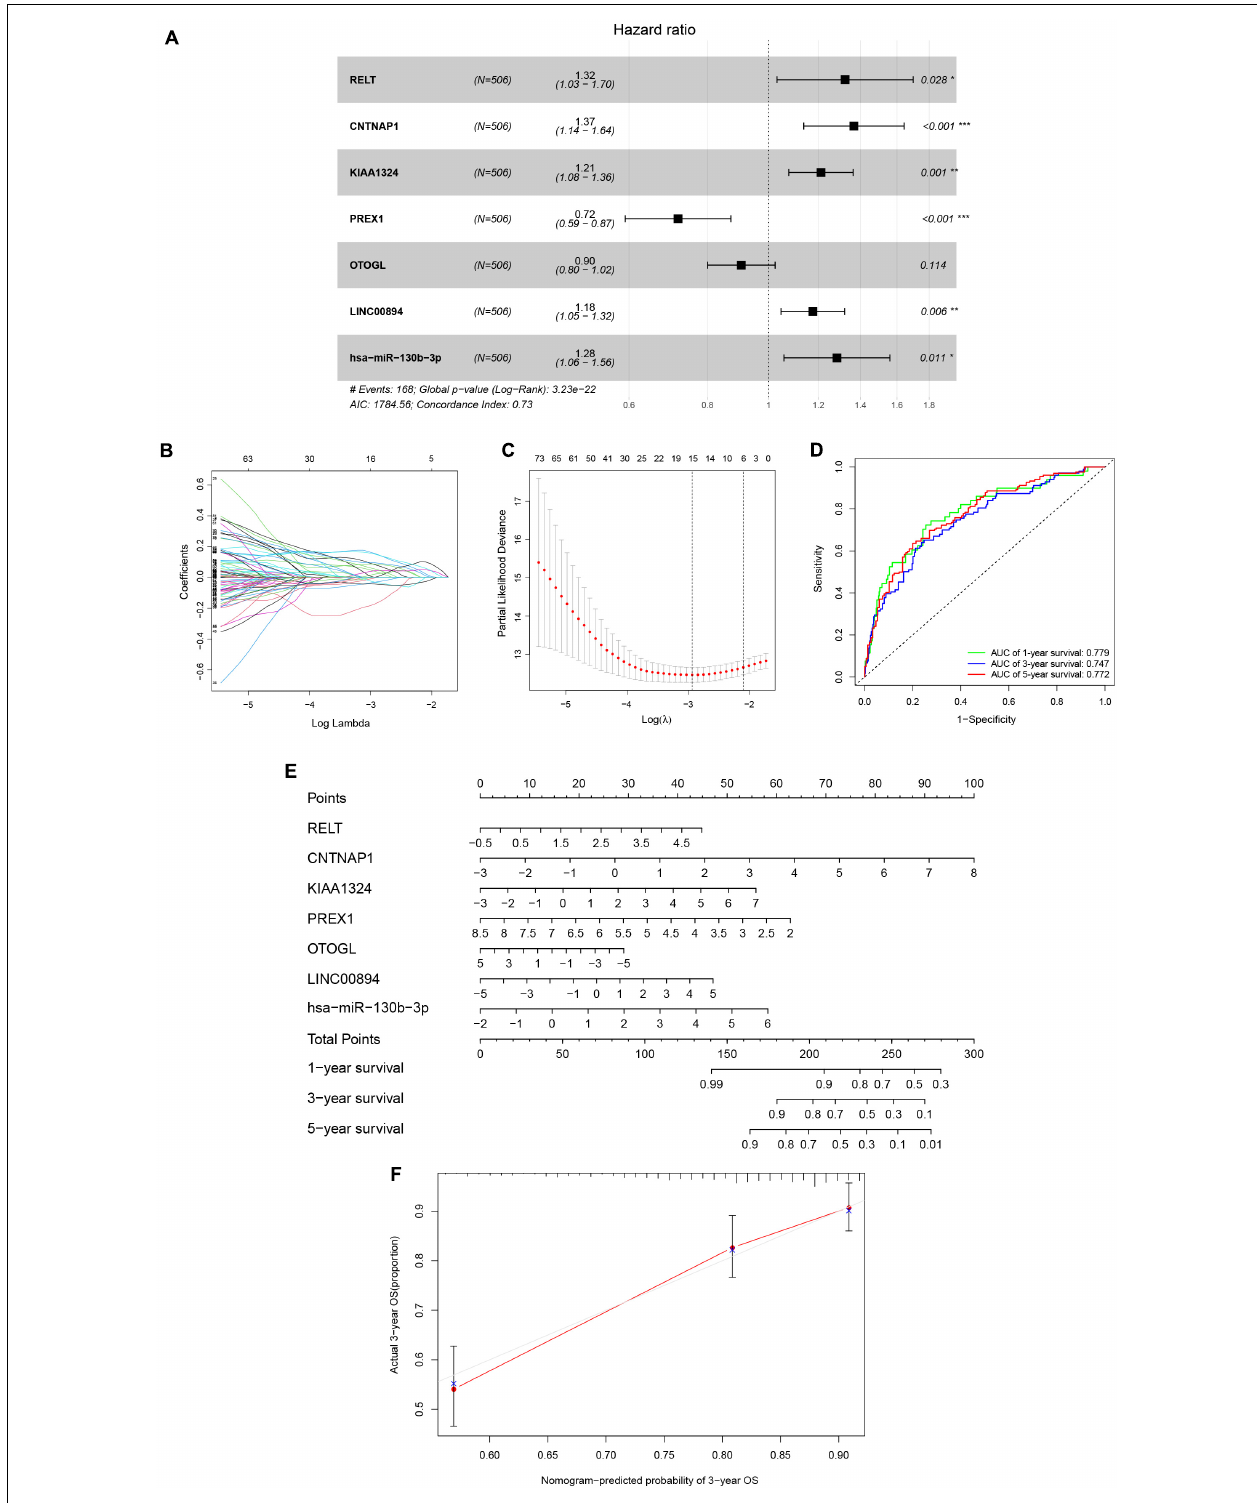
FIGURE 4 | The Cox proportional hazards regression model (A) based on RNAs screened by Lasso regression analysis (B,C) in the ceRNA network. Seven potential prognosis related RNAs were integrated into the Cox proportional hazards regression model. The nomogram (E) was constructed based on the model. The ROC (D) and calibration curves (F) indicate the acceptable accuracy (AUCs of 1, 3, and 5-year survivals: 0.779, 0.747, and 0.772) and discrimination of the nomogram. * P < 0.05; ** P < 0.010; *** P < 0.001.